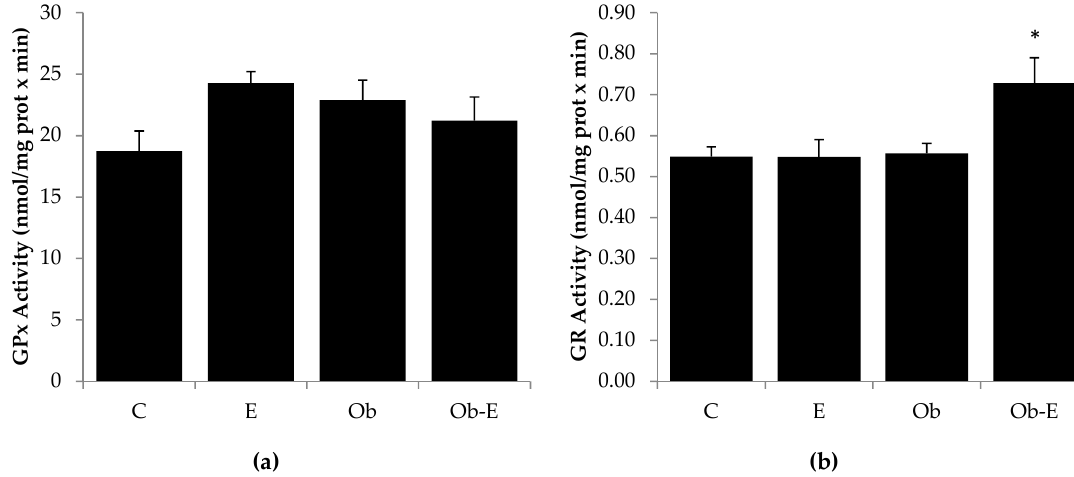
Figure 3. Effect of chronic ethanol exposure on enzymatic glutathione peroxidase (GPx) ( a ) and glutathione reductase (GR) activity ( b ) in the brain. Bars represent the mean ± SEM.* p < 0.05 vs. rest of groups. C, wild-type control; E, wild-type ethanol; Ob, Ob control; Ob-E, Ob–ethanol.